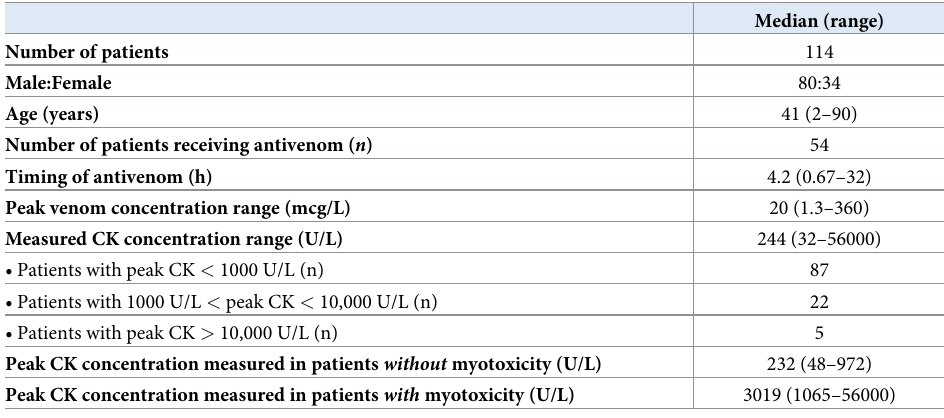
Table 1. Demographic characteristics of the study